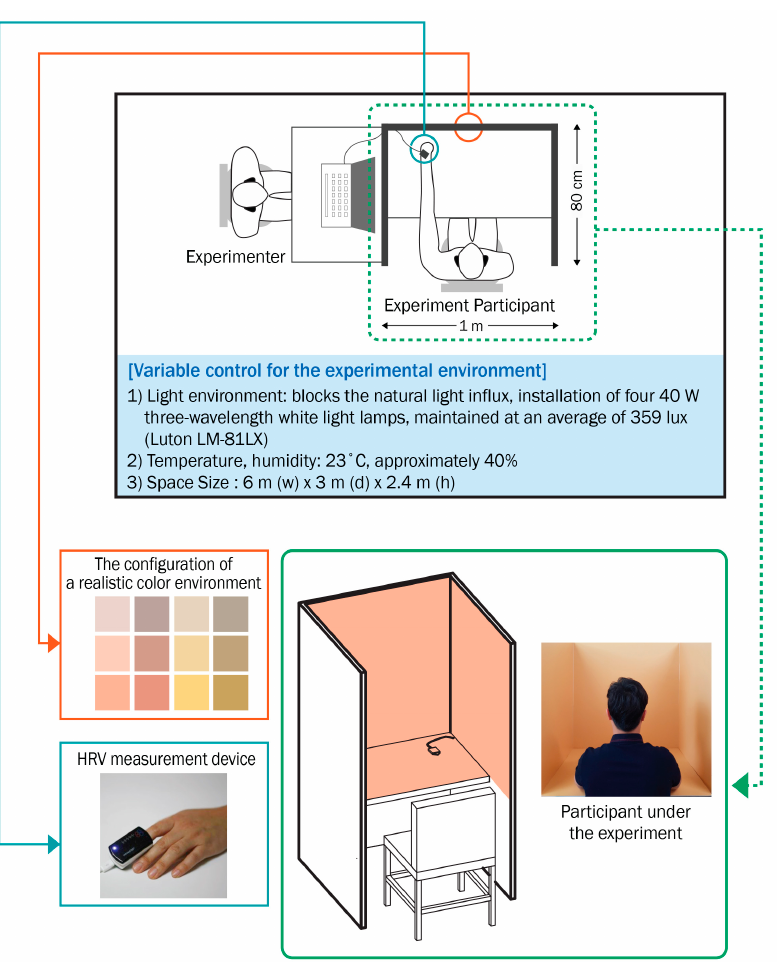
Figure 4. Experimental environment. Table 6. Specifications of experimental environment artificial lighting (Osram FHF32SS EX-D).